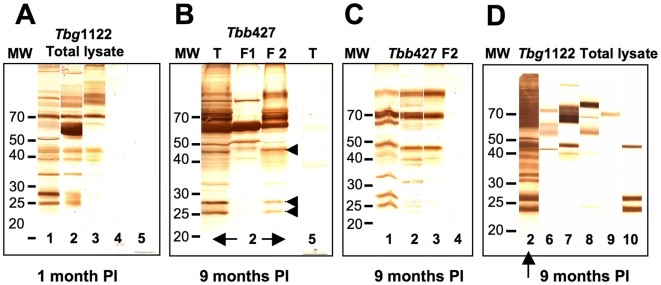
Immunoblotting analysis of the trypanosome antigens recognised during BALB/c mice infections and identification of potential immunoreactive proteins.Different trypanosome protein extracts: (3A,D) Tbg1122b total lysate, (3B) Tbb427 total lysate (T) and Tbb427 fractions containing the soluble proteins (F1) or cytoskeleton/membrane proteins (F2), (3C) Tbb427 cytoskeleton/membrane fraction (F2) were subjected to SDS-PAGE and tested by Western blotting against different sera from BALB/c (n = 4) mice infected with (103) parasites, (3A–C): sera from Tbg945b (1), Tbg1122b (2), Tbg1135b (3), Tbg1135c (4); non-infected control mice (5) or (3D) antibodies specific for cytoskeleton or membrane proteins: rabbit polyclonal antibodies directed against ISG64 (6), ISG65 (7), ISG75 (8), mouse monoclonal antibodies recognizing PFR2 (9) or calflagin (10). A–C represents the results of one representative immunoblot out of 4 mice tested.